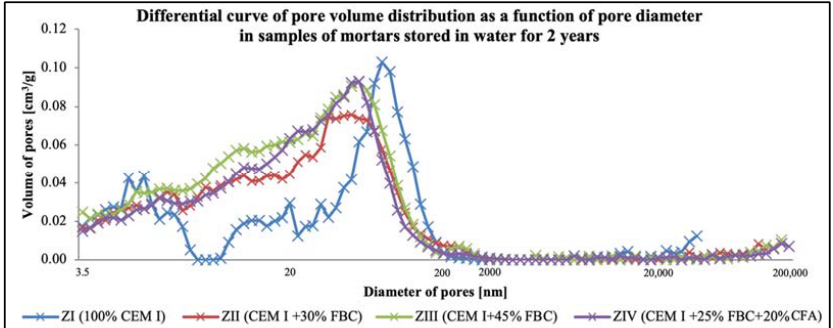
Figure 19. Differential curve of pore volume distribution as a function of pore diameter in samples of mortars stored in water for 730 days.